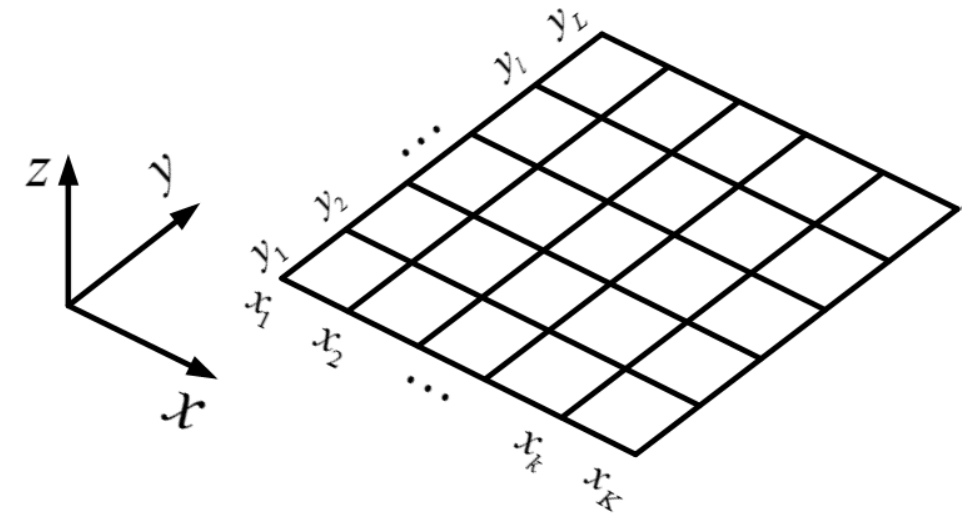
Figure 3. The grid division of imaging scene.